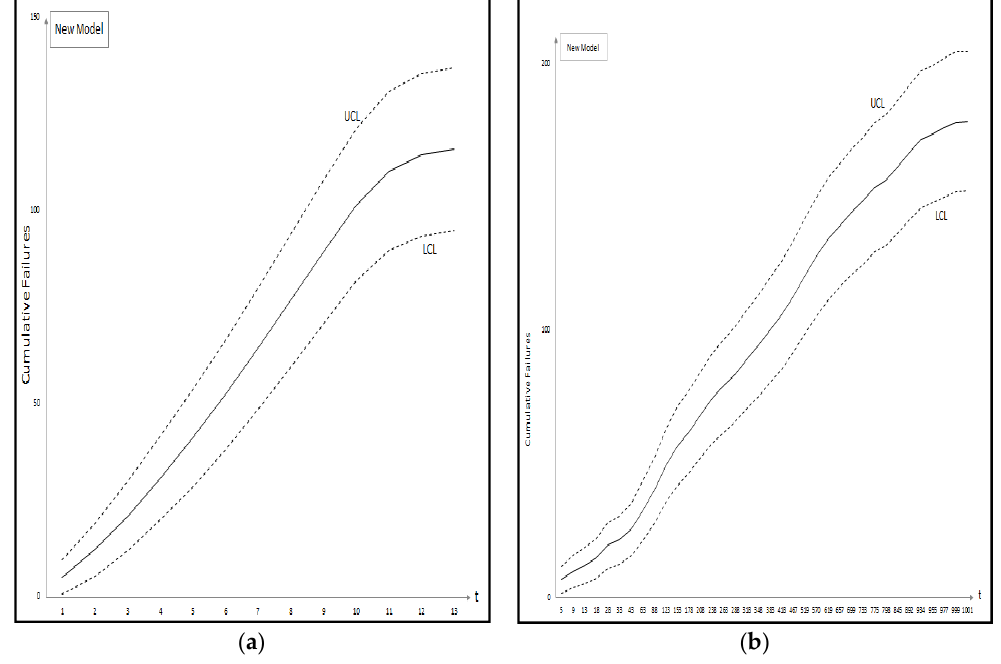
Figure 4. Confidence intervals of the proposed new model; ( a ) Dataset #1; ( b ) Dataset #2.